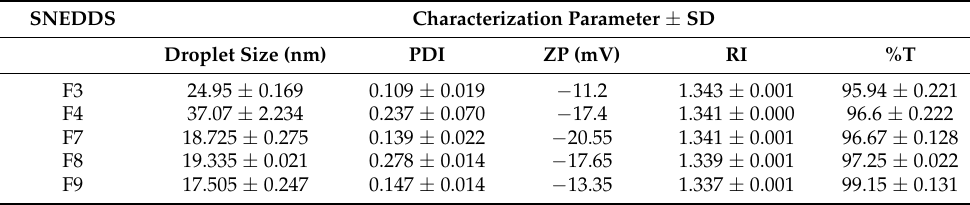
Table 4. Physicochemical characterization of APR-SNEDDS.